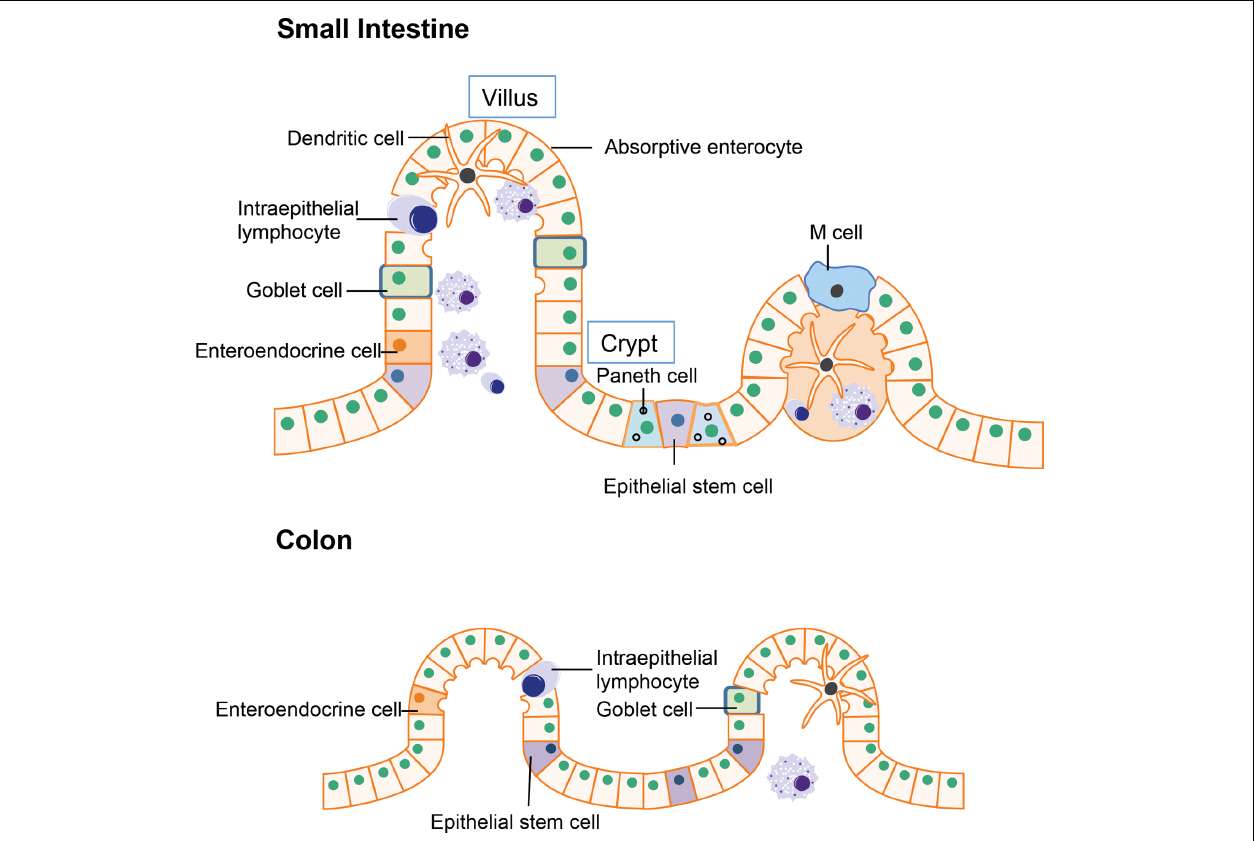
FIGURE 1 | Structure of gut epithelium. In the small intestine, the epithelial stem cells located in the crypt differentiate into four cell types: the absorptive enterocytes, enteroendocrine cells, goblet cells, and paneth cells. In the colon, the epithelial stem cells are usually located in the lower parts of gut crypts and the differentiated cells migrate to the higher position and populate the colonic epithelial surface.